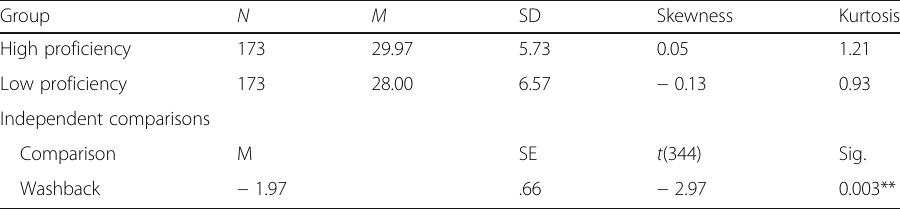
Table 3 The t test for independent samples comparing the mean difference in the strength of washback experienced between high-proficiency and low-proficiency students Group N M SD High proficiency Independent comparisons